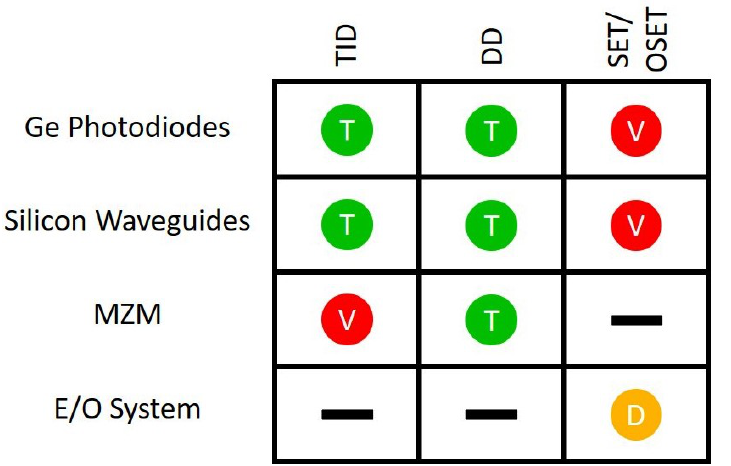
Figure 14. Summary of the current state of radiation effects in silicon photonic components. Green “T” means tolerant to radiation; red “V” means vulnerable to radiation; yellow “D” signifies that the system can be hardened by design techniques; and the black dashes means that there is currently no radiation data in the